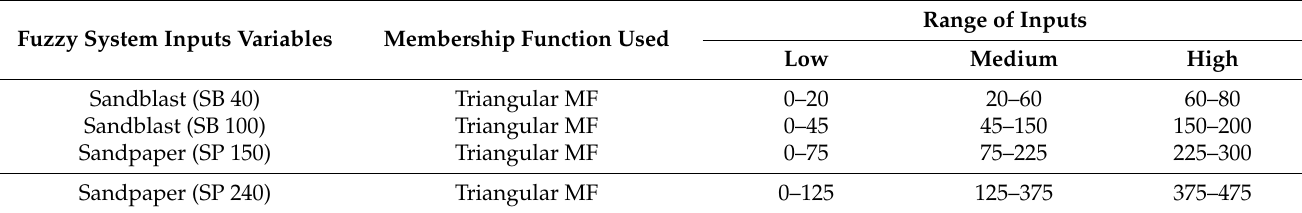
Table 3. Membership Functions of Fuzzy System Inputs.